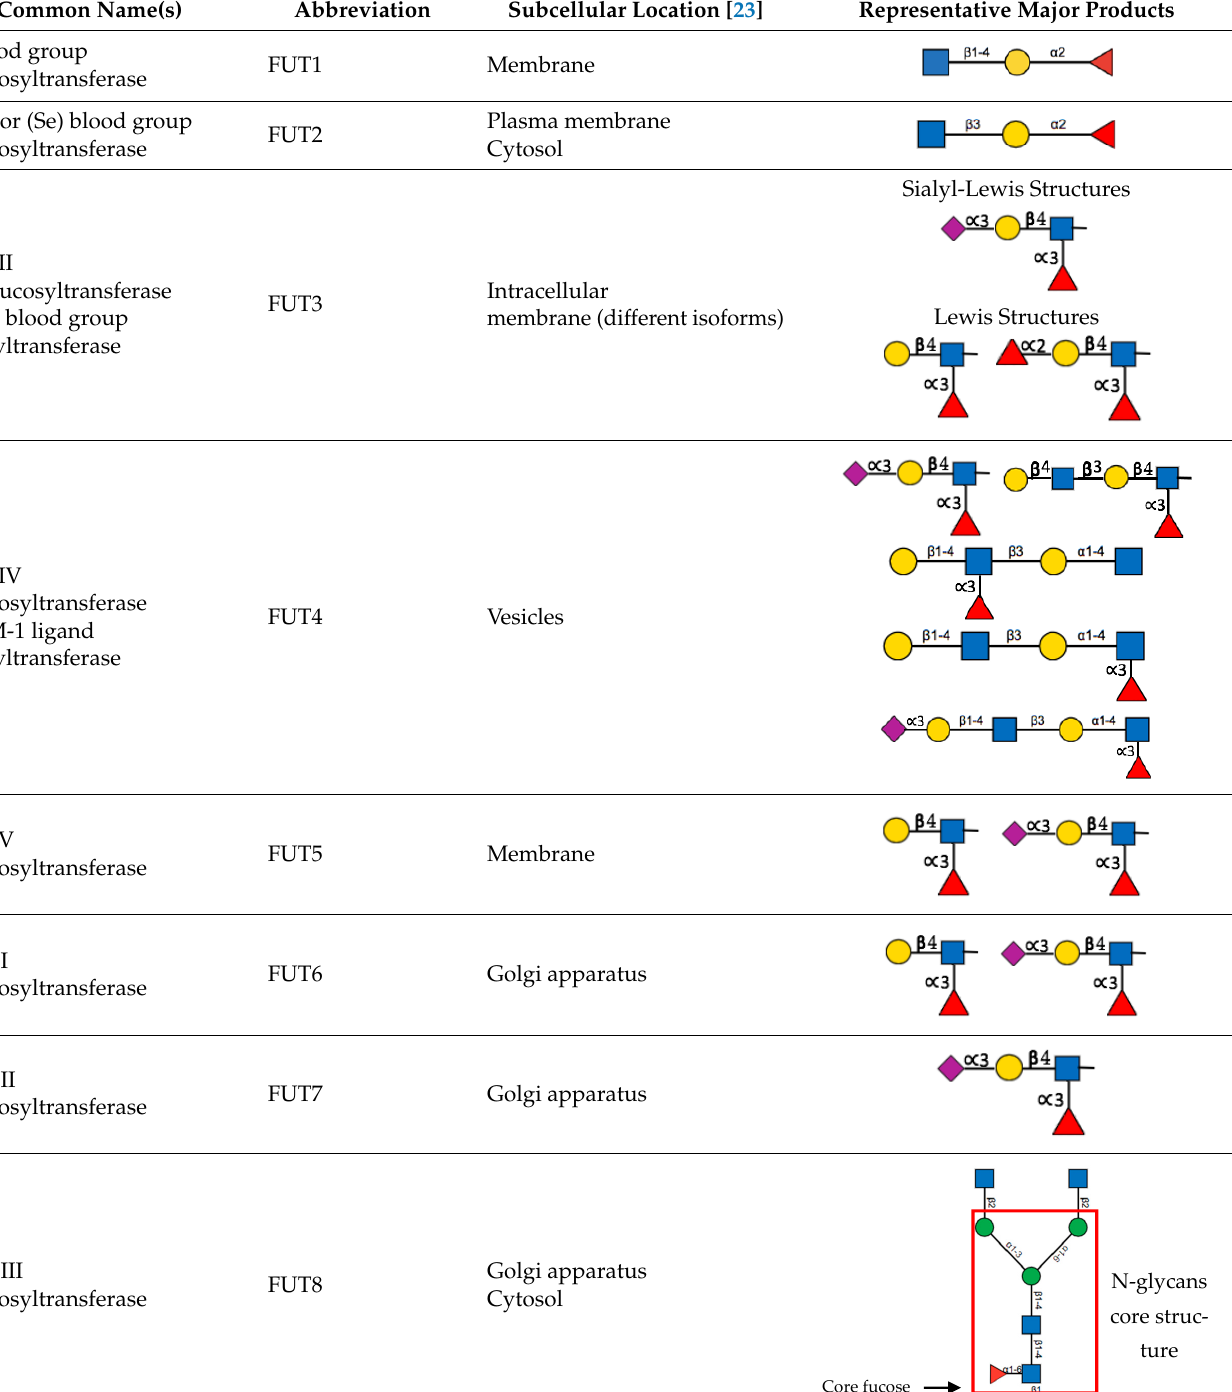
Table 1. Known fucosyltransferases in Humans. Adapted from [18,21] and created with GlycoGlyph